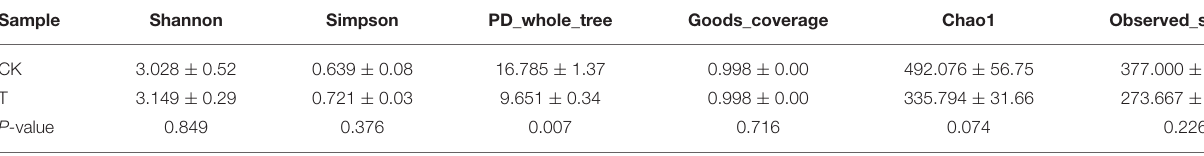
TABLE 3 | Differences in samples alpha diversity.